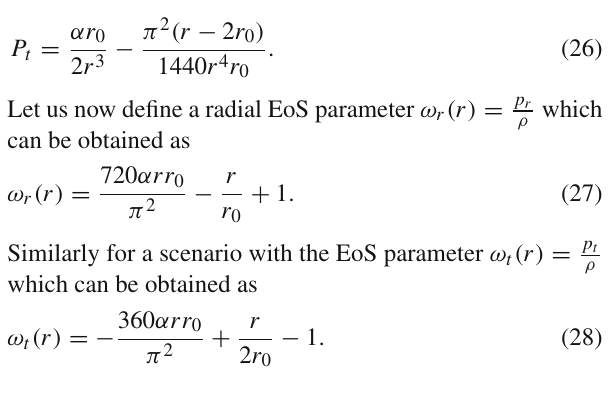
Fig. 1 Shape function and flare-out condition for parallel plates with r 0 = 1